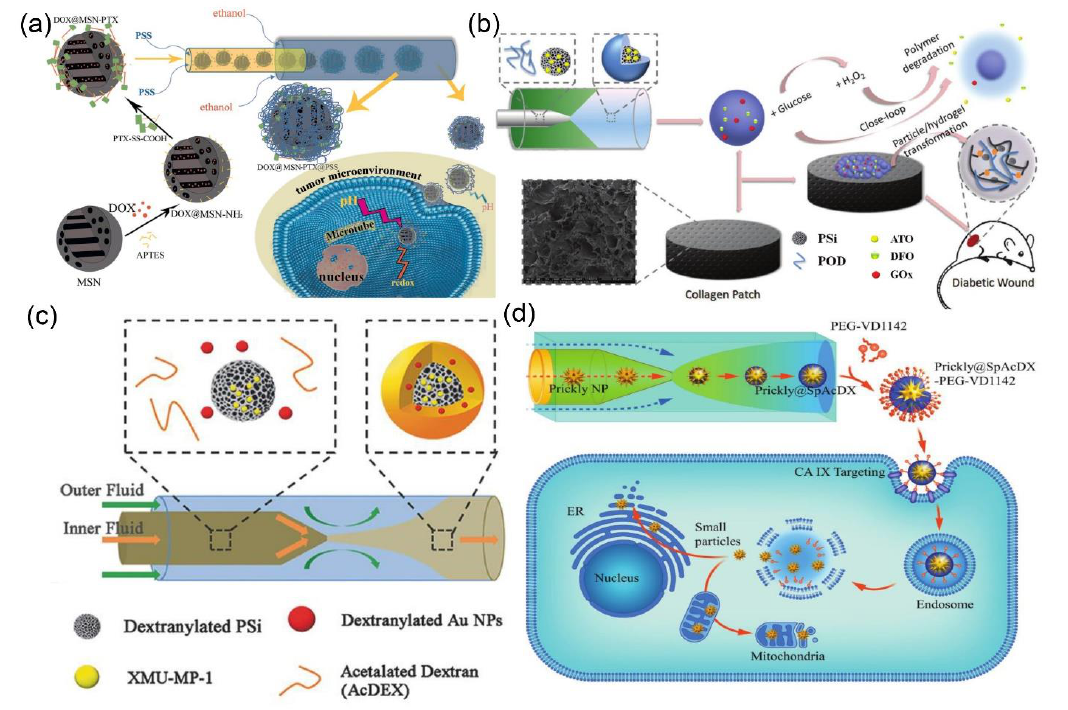
Figure 12. ( a ) Schematic illustration for the synthesis of DOX@MSN-PTX and the microfluidic fabrication of DOX@MSN-PTX@PSS (reproduced from [164], with permission from the American Chemical Society, 2020). ( b ) Schematic illustration for the construction of glucose-responsive delivery system and the orchestrated cascade for diabetic wound care (reproduced from [165], with permission from the Royal Society of Chemistry, 2019). ( c ) Schematic illustration of synthesis procedure of multifunctional nanoparticles by